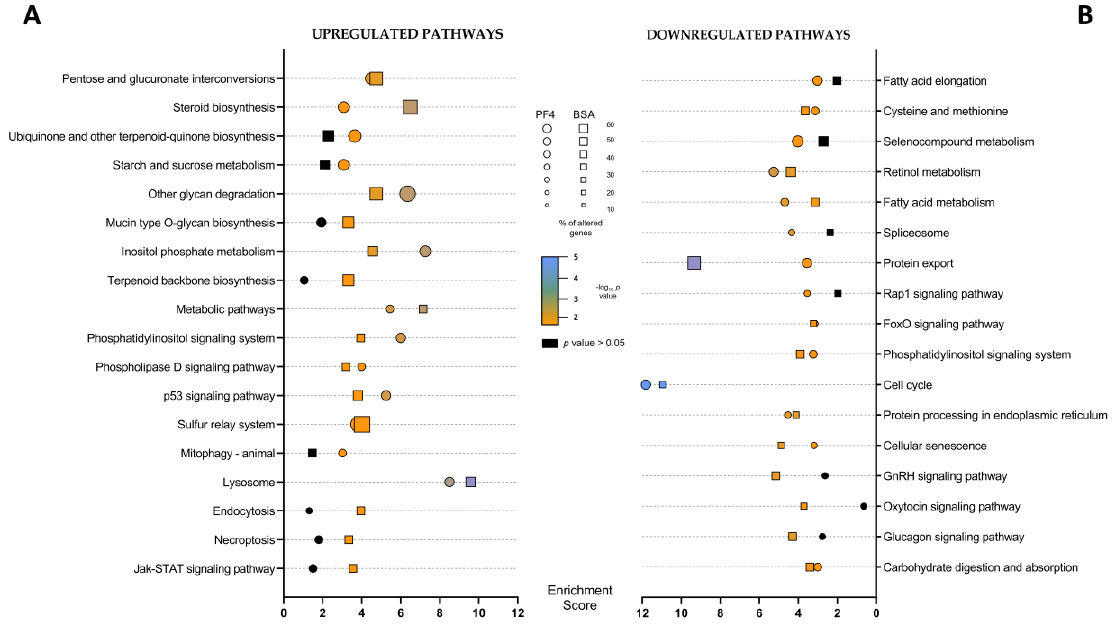
Figure 5. Representation of the different pathways considered altered ( p value < 0.05) obtained from the ( A ) upregulated differentially expressed genes (upregulated pathways) and from ( B ) the downregulated differentially expressed genes (downregulated pathways). The enrichment values for each pathway are indicated by a circle in the case of the comparison between in vitro embryos cultured in defined medium (PF4: platelet factor 4) and in vivo-derived embryos (IVV) and by a square in the case of the comparison between in vitro embryos cultured in undefined medium (BSA: bovine serum albumin) and IVV embryos. The size of the symbol indicates the percentage of affected genes out of the total number of genes belonging to that pathway. The color of the symbol indicates the p-value of each